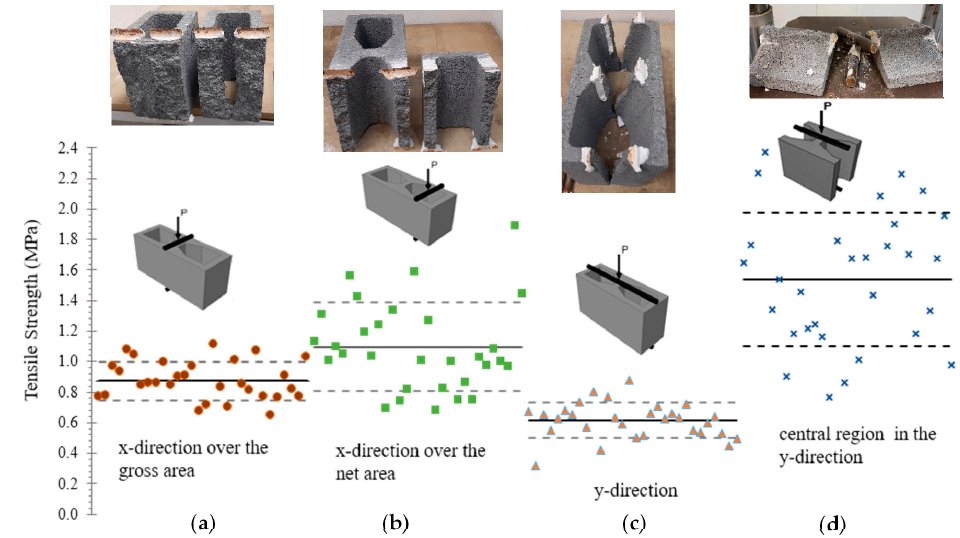
Figure 5. Failure mode and tensile strength results from the splitting tests: ( a ) x-direction over the gross area, ( b ) x-direction over the net area, ( c ) y-direction, and ( d ) 200 mm from the central region of the block in the y-direction.